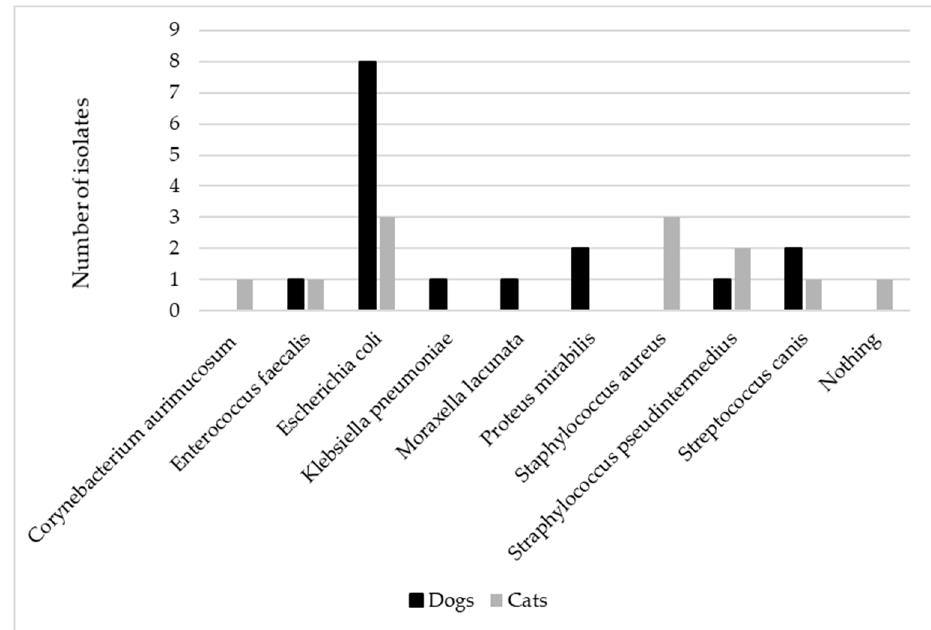
Figure 1. The figure represents the distribution of the different bacteria isolated in canine ( n = 14) and feline ( n = 11) urine samples collected by cystocentesis in patients presenting acute signs of urinary tract infection.